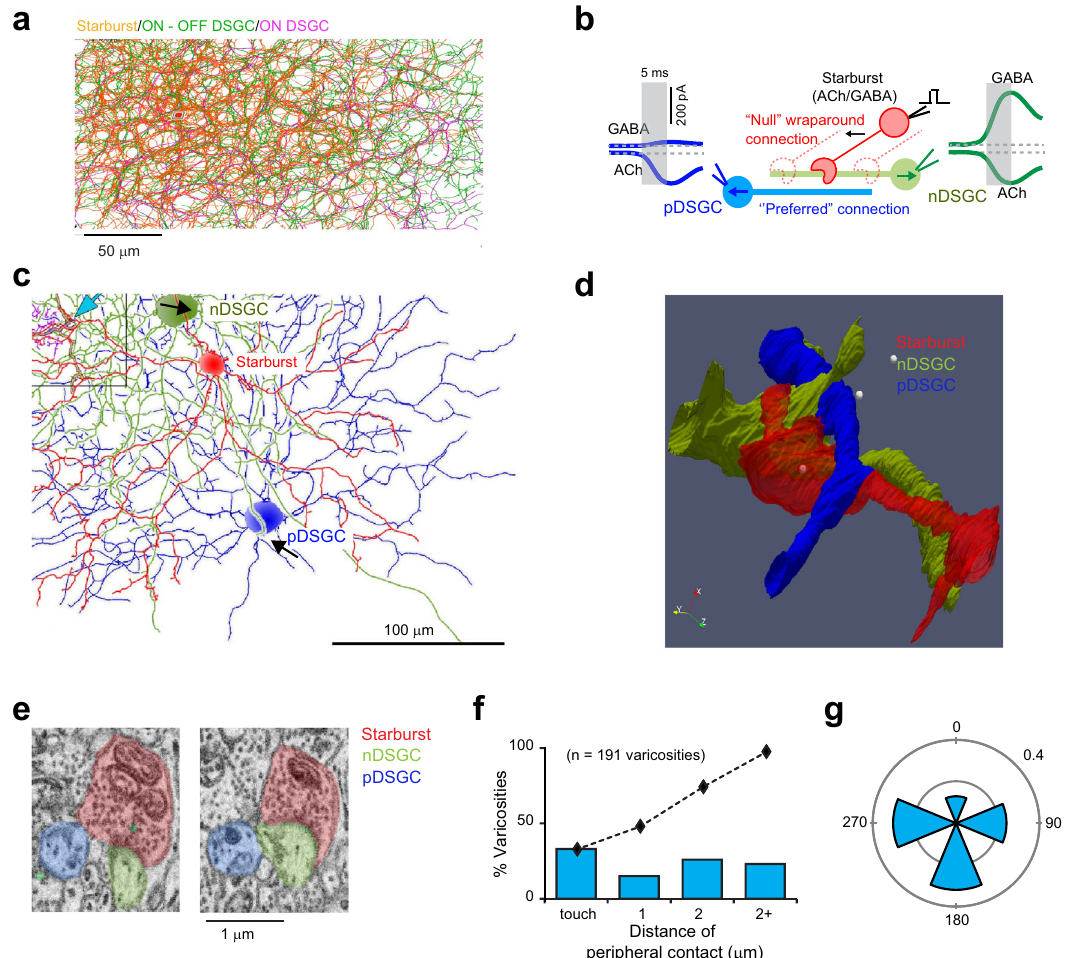
Fig. 1 SBEM analysis reveals putative sites of cholinergic transmission. a A fl at-mount view of a small section of the inner-plexiform layer in the retina showing the dendrites of 82 ON GABAergic/cholinergic starburst amacrine cells and 32 ON-OFF DSGCs (both ON and ON-OFF DSGCs are shown) reconstructed from an existing SBEM dataset 26 . These partially reconstructed dendrites show the typical “ honeycomb ” plexus formed by the high level of co-fasciculation in the starburst/DSGC dendrites (See Supplementary Fig. 1a for a cross-sectional view). Starburst varicosities, which release ACh and GABA, are distributed over their distal dendrites (markers in Supplementary Fig. 1b). b Starburst dendrites respond preferentially to centrifugal motion (soma-to dendrite); their varicosities “ wraparound ” and make strong synaptic contacts selectively with DSGCs encoding the opposite direction (nDSGC; arrows indicate directional preferences). These are considered ‘ null connections ’ because stimulation of the starburst through a patch electrode evokes large GABAergic responses that dwarf the cholinergic responses co-activated in the synaptically connected nDSGCs. Stimulation of the same starburst evokes only cholinergic (but not GABAergic) currents in DSGCs encoding the opposite direction (pDSGC) through ‘ preferred ’ connections. The differential transmission of ACh/GABA aids in shaping direction selectivity 31,32 , but its cellular basis remains unknown. c Flat-mount view of the reconstructed dendrites of two opposite coding DSGCs (blue/pDSGC, green/nDSGC) and a starburst (red) (the coding preferences of the DSGCs are shown by the black arrows; see Supplementary Fig. 1b for how the coding preferences of DSGCs were anatomically determined 25 ). Blue arrow (top left) points to the location of the synapse between the red starburst and green nDSGC. Also shown are the dendrites of a Type 5o bipolar cell (pink), which makes a ribbon synapse with the red starburst and pDSGC. d A zoomed-in version of the synapse shown in ( c ). The starburst dendrite (red) makes a wraparound null contact (white spheres) with the nDSGC (green), and a peripheral contact with the pDSGC (blue). e Cross-sections illustrating the ultrastructural features of the tripartite complex in ( d ). The electron-dense postsynaptic density is evident at the wraparound synapse with nDSGC but not with the “ peripheral ” point of contact with the pDSGC. f Distribution of distances between a starburst varicosity and its closest peripheral contact ( n = 191 varicosities contacting 6 independent ON-OFF DSGCs in 1 retina). Dotted line shows the cumulative distribution function. g The distribution of the directional preference of the DSGCs making peripheral contacts ( n = 115 varicosities, 6 DSGCs from 1 retina), shown relative to the DSGCs receiving the wraparound contacts. The data is shown as a relative fraction of the total varicosities. Source data are provided as a Source Data fi le for Fig. 1f, evidence that diffusion of ACh released from single vesicles can correlations in sEPSC activity as a ratio of the peak amplitudes of rapidly activate currents at multiple postsynaptic sites on different the STA and the average sEPSC. Over the population, the neurons. Such “ multi-directed ” cholinergic transmission chal- magnitude of correlated activity was 0.12 ± 0.01 ( n = 7 pairs; lenges the idea that rapid sEPSCs signify transmission through Fig. 2d). The low rate of sEPSCs (~3 Hz) made it highly conventional nanodomain-coupled synaptic mechanisms. unlikely that the strength of the observed correlations arose by Several control experiments and analyses bolster these conclu- chance from independent sources (probability = 0.003 2 ∗ 100 = 0.0009%). Thus, we interpret these correlated sEPSCs as direct sions. The distribution of the peak amplitudes of the correlated